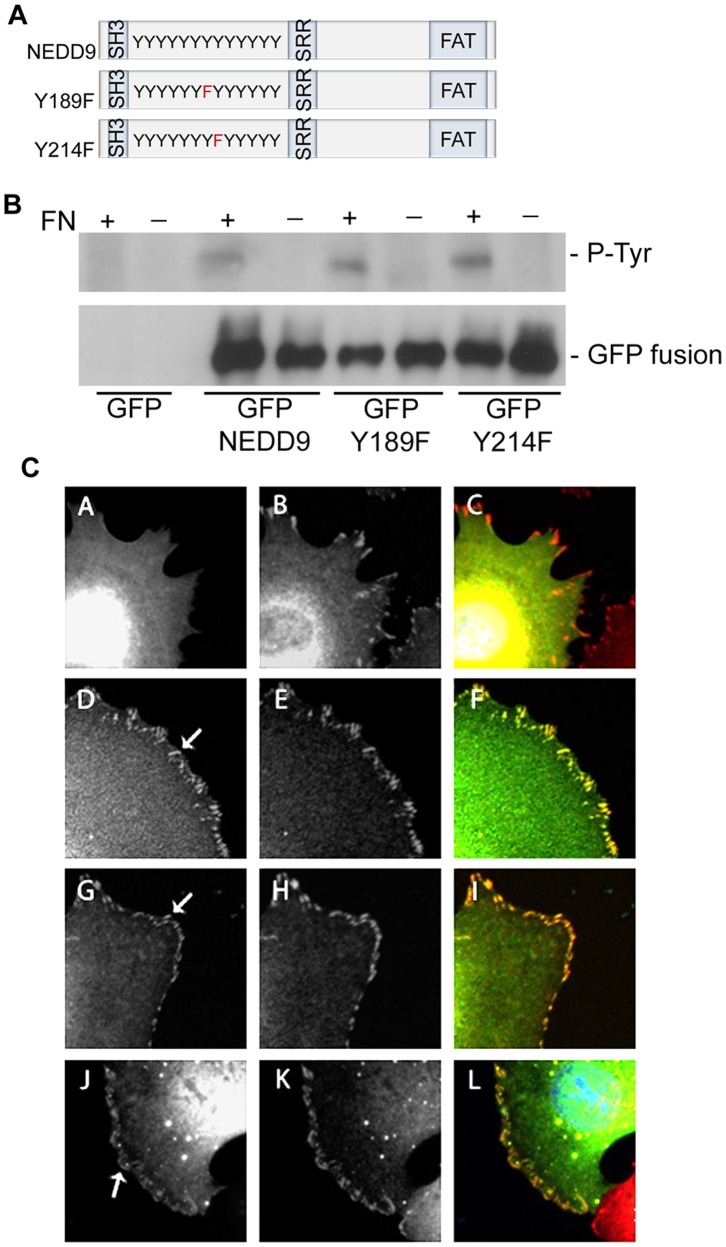
NEDD9 mutations do not affect global tyrosine phosphorylation or targeting to focal adhesions.A. Schematic representation of NEDD9 protein sequence showing the N-terminal SH3 domain, substrate domain containing 13 consensus tyrosine phosphorylation motifs (Y), the serine rich domain (SRR) and the Focal Adhesion Targeting domain (FAT). The two mutated tyrosine residues are indicated in red in the Y189F and Y214F schematic representations. B. Cells transfected with the indicated expression constructs were held in suspension (–) or suspended and then plated onto fibronectin (+). NEDD9 immunoprecipitates were probed with antibodies to phosphotyrosine (P-Tyr) and with anti-NEDD9 antibodies (GFP fusions). C. Cells transfected with GFP vector (A–C), GFP.NEDD9 (D–F), GFP.NEDD9 Y189F (G–I) and GFP.NEDD9 Y214F (J–L). Left hand panels show GFP fluorescence images, middle panels show paxillin immunostaining and merged images are shown on the right. Arrows point to examples of positive focal adhesions. Each image shows a cropped region of one cell.